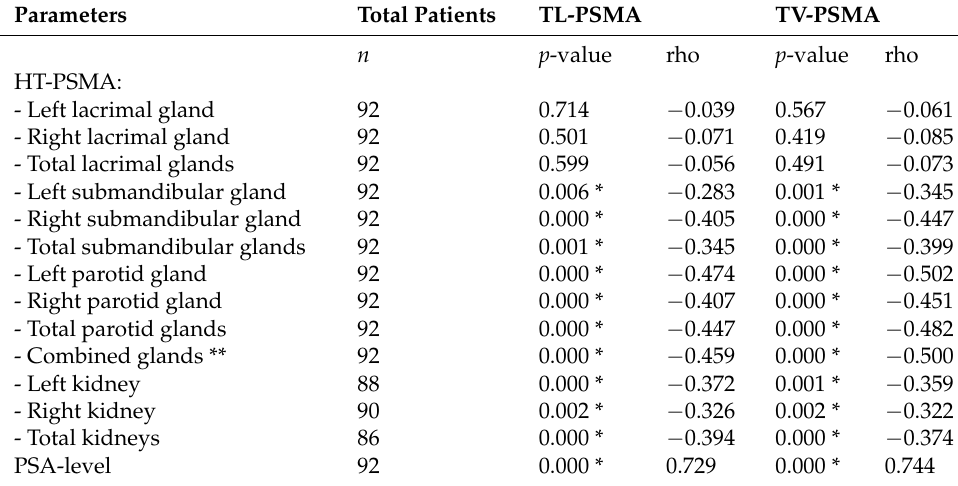
Figure 4. Correlation between the PSA value and the fractional total lesion [68Ga]Ga-PSMA-11 uptake volume (TL-PSMA) and PSA and the PSMA-derived total tumor volume (TV-PSMA) in men with metastatic prostate cancer.